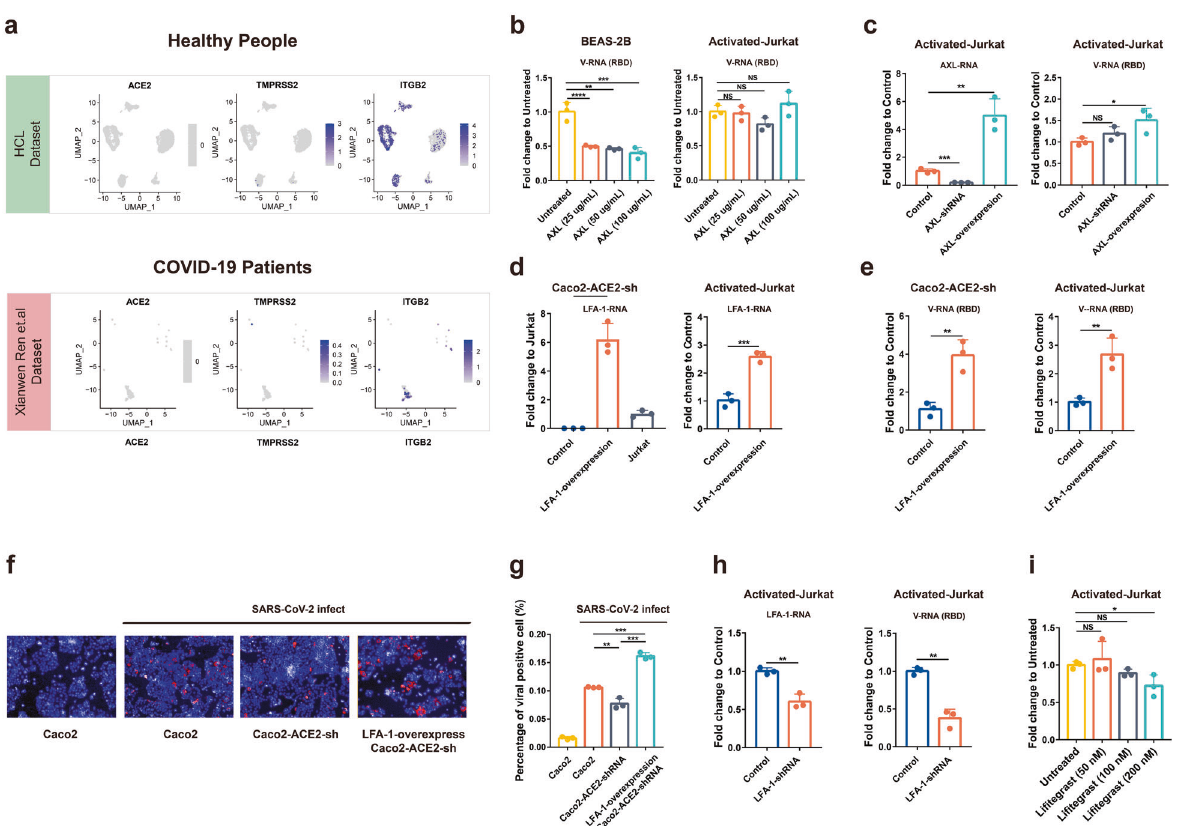
Fig. 5 Exploration of potential receptors in T cells. a The expression of ACE2, TMPRSS2, and ITGB2 (LFA-1) in blood T cells from healthy donors and COVID-19 patients. The analysis is dependent on public single-cell NGS data. 14 The expression of the three genes is indicated in SARS- CoV-2 viral RNA-positive T cells for patient penal. b BEAS-2B and activated Jurkat cells were incubated with different concentrations of AXL proteins (25, 50, or 100 μ g/ml) at 37 °C for 30 min before infected by SARS-CoV-2 (MOI of 0.01). Intracellular viral RNA (RBD) at 24 h post infection was quanti fi ed using qPCR. c Knockdown or overexpression of AXL were performed on Jurkat cells and the expression level of AXL was detected using qPCR. Cell lines were infected by SARS-CoV-2 at an MOI of 0.01 for 24 h and viral RNA was quanti fi ed. d LFA-1 was stably overexpressed on ACE2 knockdown Caco2 (Caco2-ACE2-shRNA) or Jurkat cells, and the RNA level was quanti fi ed using qPCR. e Caco2, activated Jurkat and their respective LFA-1-overexpression cells were infected by SARS-CoV-2 at an MOI of 0.01 and harvested at 24 h post infection. Intracellular viral RNA was detected using qPCR. f , g Caco2, Caco2-ACE2-shRNA, and its LFA-1 overexpression cell line were infected by SARS-CoV-2 at an MOI = 5 for 8 h. The high content microscope was used to observe ( f ) and quantify ( g ) the viral NP-positive cells. h LFA-1 knockdown Jurkat cells were infected with SARS-CoV-2 (MOI = 0.01) for 24 h, and the expression of LFA-1 and intracellular viral RNA was analyzed using qPCR. i Activated Jurkat cells were pretreated with Li fi tegrast, an inhibitor of LFA-1 at different concentrations (50, 100, or 200 nM) at 37 °C for 30 min before infection (MOI = 0.01). Intracellular viral RNA was quanti fi ed at 24 h post infection. The statistics was performed using Student ’ s t test (* P < 0.05; ** P < 0.01; *** P < 0.001; **** P < 0.0001; NS no signi fi RNA-seq analysis to primary peripheral blood mononuclear cells (PBMCs) collected from three healthy donors and three severe COVID-19 patients. Our data showed an upregulation of cell responses to stimuli, cell death, or response to hypoxia pathways, and a down-regulation of leukocytes activation and signaling pathways, similar to the fi ndings in the T-cell line (Fig. 4e). In summary, SARS-CoV-2 infection induced pronounced T-cell death, which is probably dependent on mitochondria ROS-hypoxia pathways.